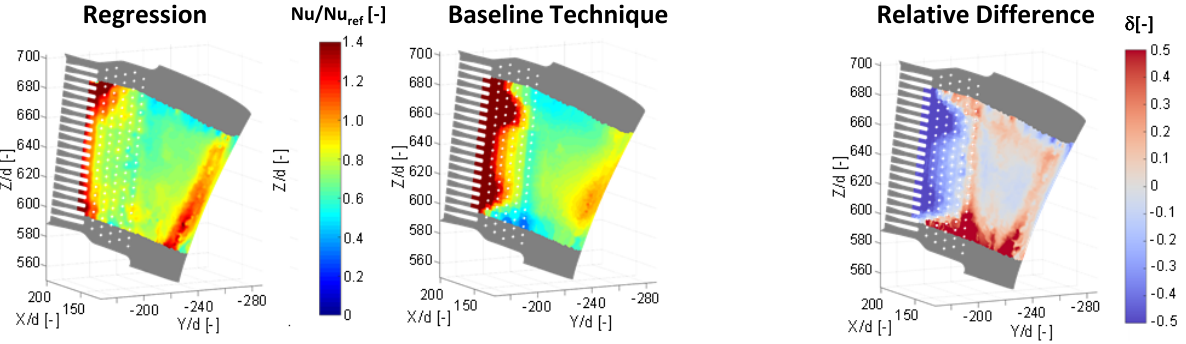
Figure 10. Heat transfer distribution obtained by the regression and the baseline technique and relative difference for the maximum Re